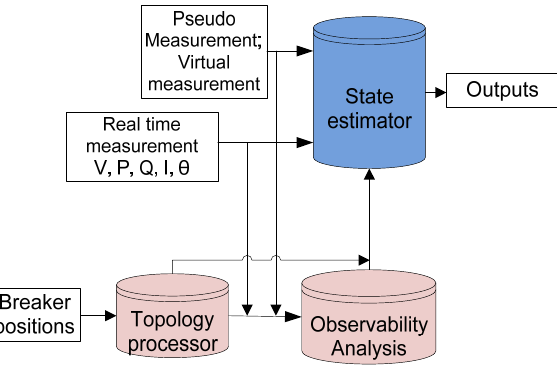
Figure 2. Illustration of state estimation (SE) processes .